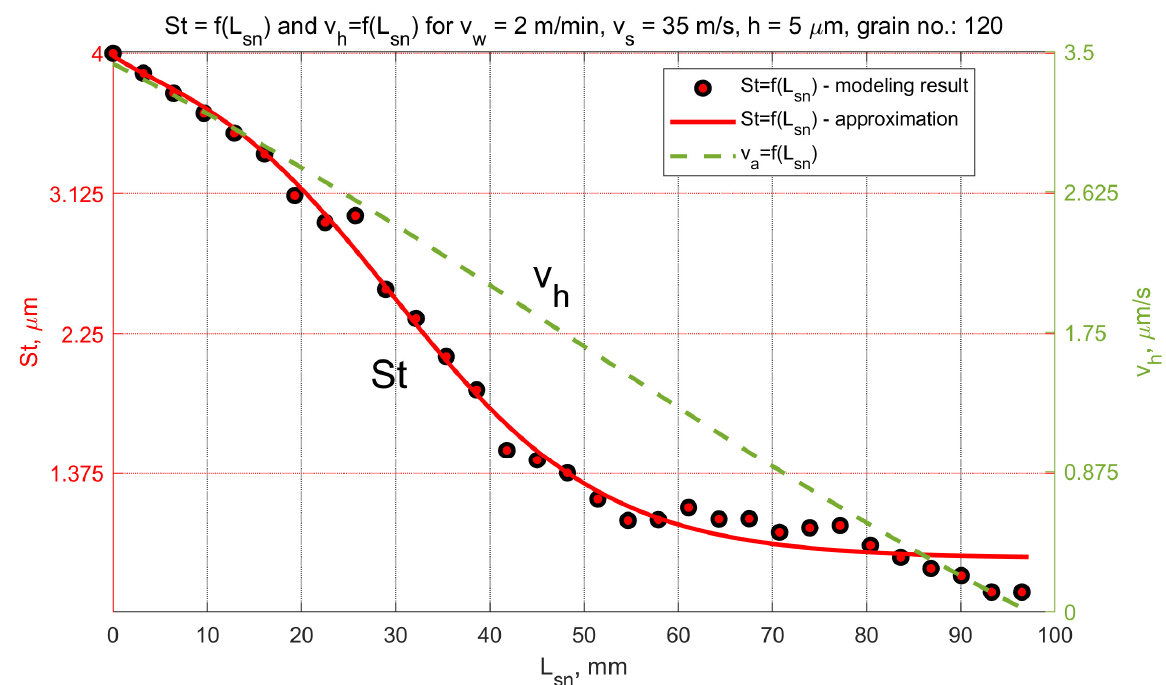
Figure 15. Changes in the St parameter as a function of the grinding path for a grinding depth of h = 5 µm.